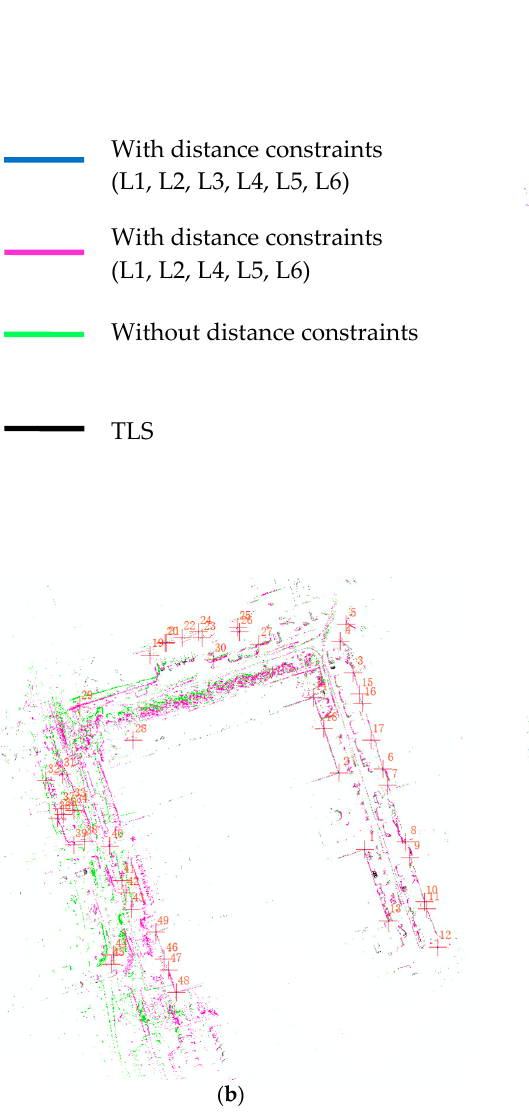
Figure 7. MAP_A: result of adding all distance constraints (L1, L2, L3, L4, L5, L6); MAP_B: result of adding distance constraints of Delaunay triangulation network (L1, L2, L4, L5, L6); MAP_C: result without any distance constraints; MAP_D: high precision TLS reference map; ( a ) comparison of MAP_A and MAP_B; ( b ) comparison of MAP_B and MAP_C, MAP_D; ( c ) comparison of MAP_A and MAP_C,